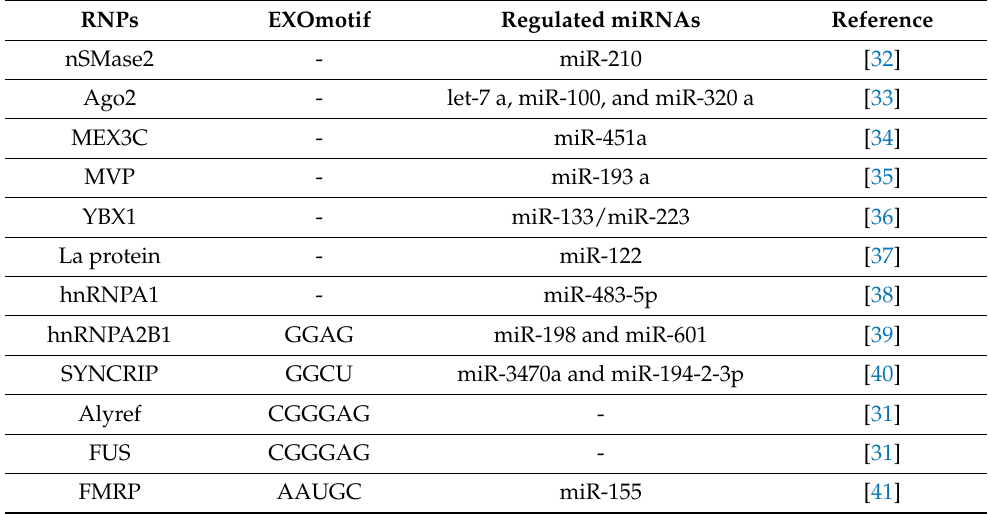
Table 1. List of RNA-binding proteins (RNPs) involved in exosomal microRNA (miRNA)